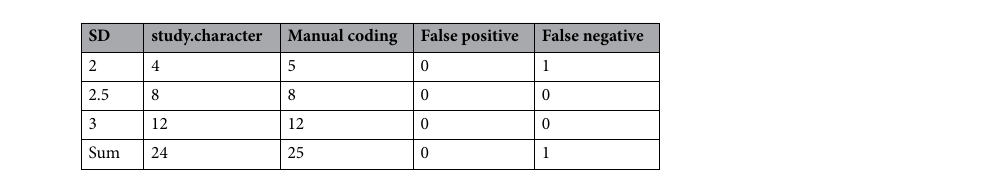
Table 9. Absolute frequencies of extracted outlier definition expressed in standard deviations (SD).